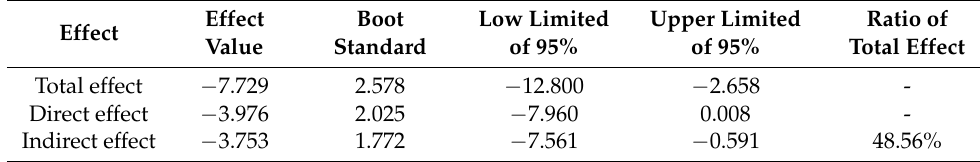
Table 4. Analysis of mediating effects of environmental risk